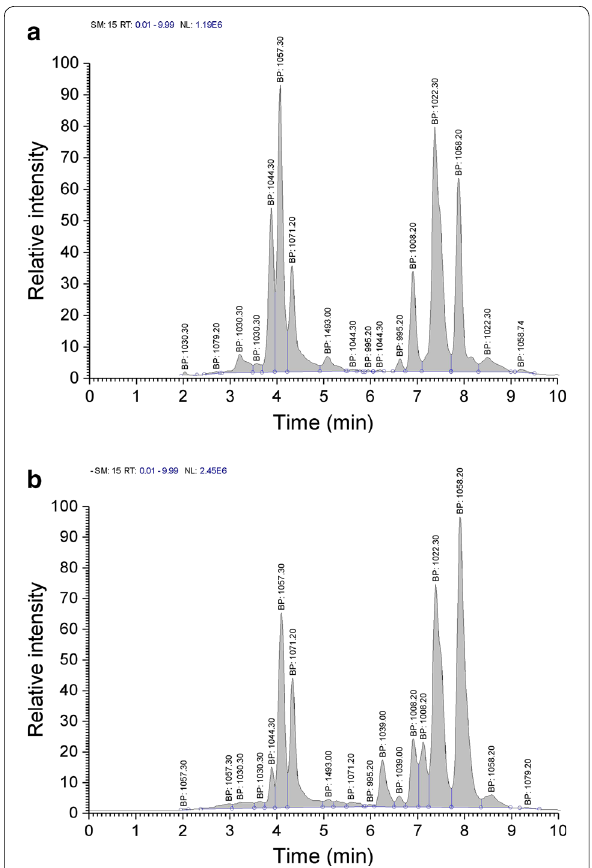
LF liquid fermentation, SSF solid state fermentation